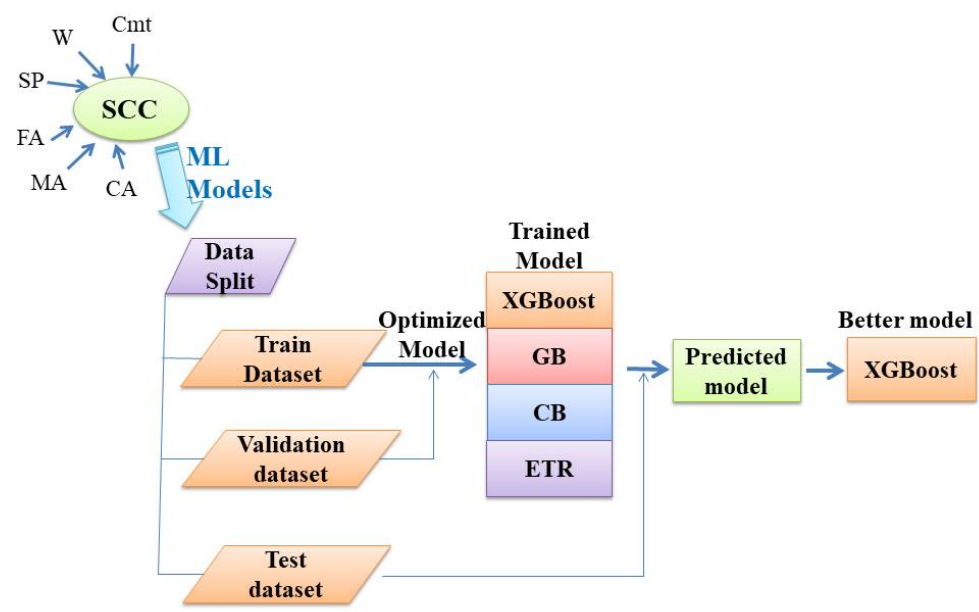
Figure 1. Machine learning